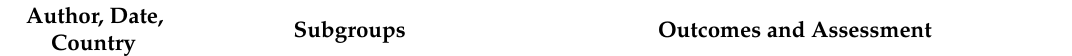
Table 3. Summary of included Studies Outcomes and